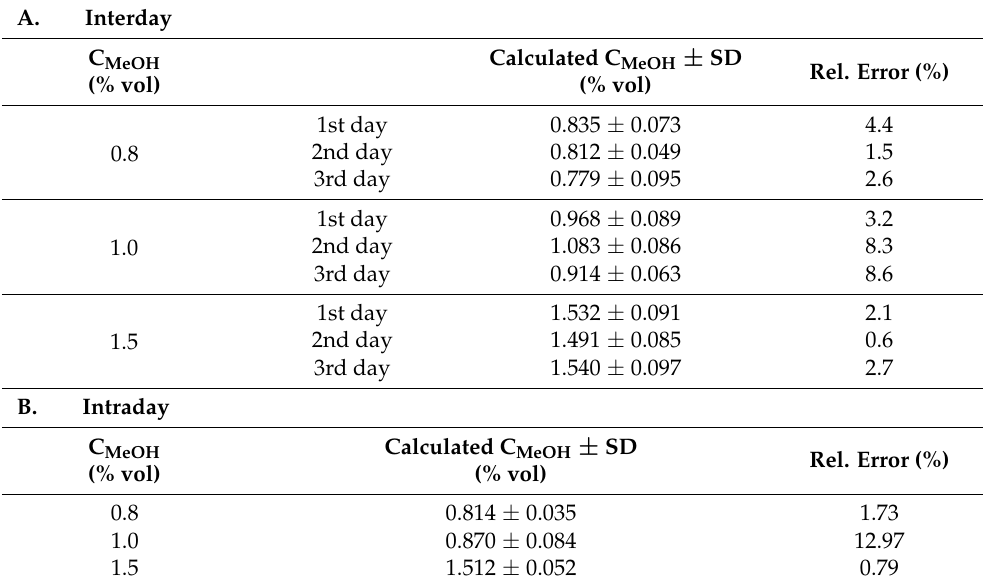
Table 5. Interday and intraday repeatability tests for the methanol–whiskey standard solutions.